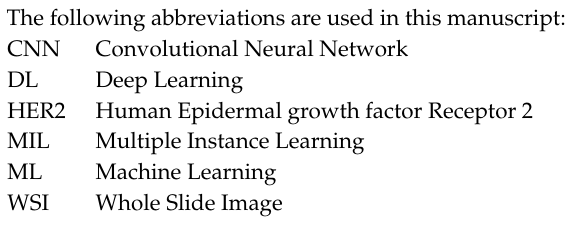
Supplementary Materials: The software and trained models are available online at https://github.com/MITEL-